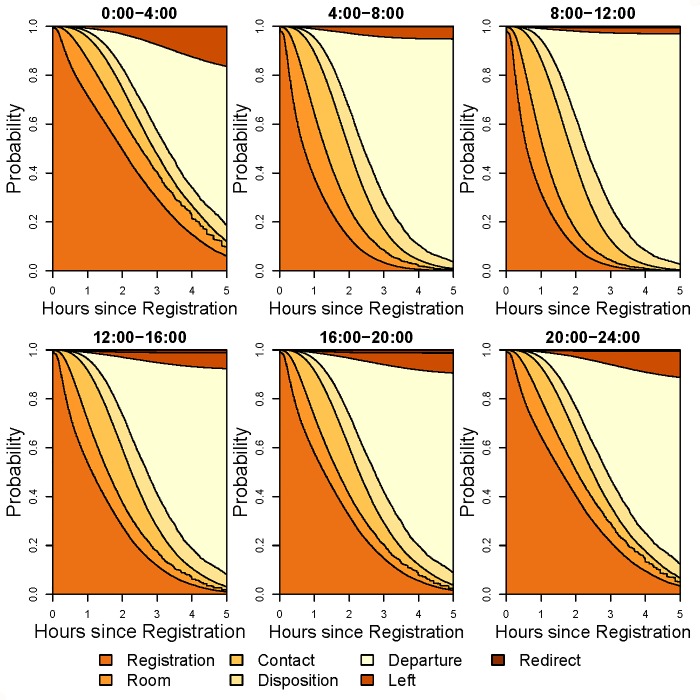
Stacked transition probabilities of the ED multistate model for different times of the day.Transition probabilities are conditional on age = 1 year, gender = male, ethnicity = not Hispanic or Latino, race = white, ESI = 4, season = winter. The number of ED physicians for each time of day was set to the median value for that period, as follows: 0:00–4:00 = 7, 4:00–8:00 = 3, 8:00–12:00 = 5, 12:00–16:00 = 6, 16:00–20:00 = 8, 20:00–24:00 = 8.